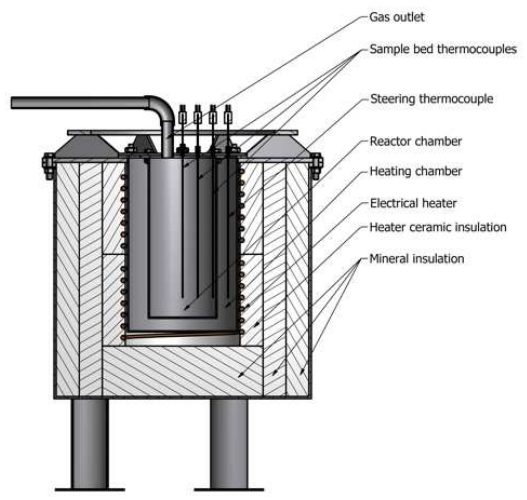
Figure 2. The experimental